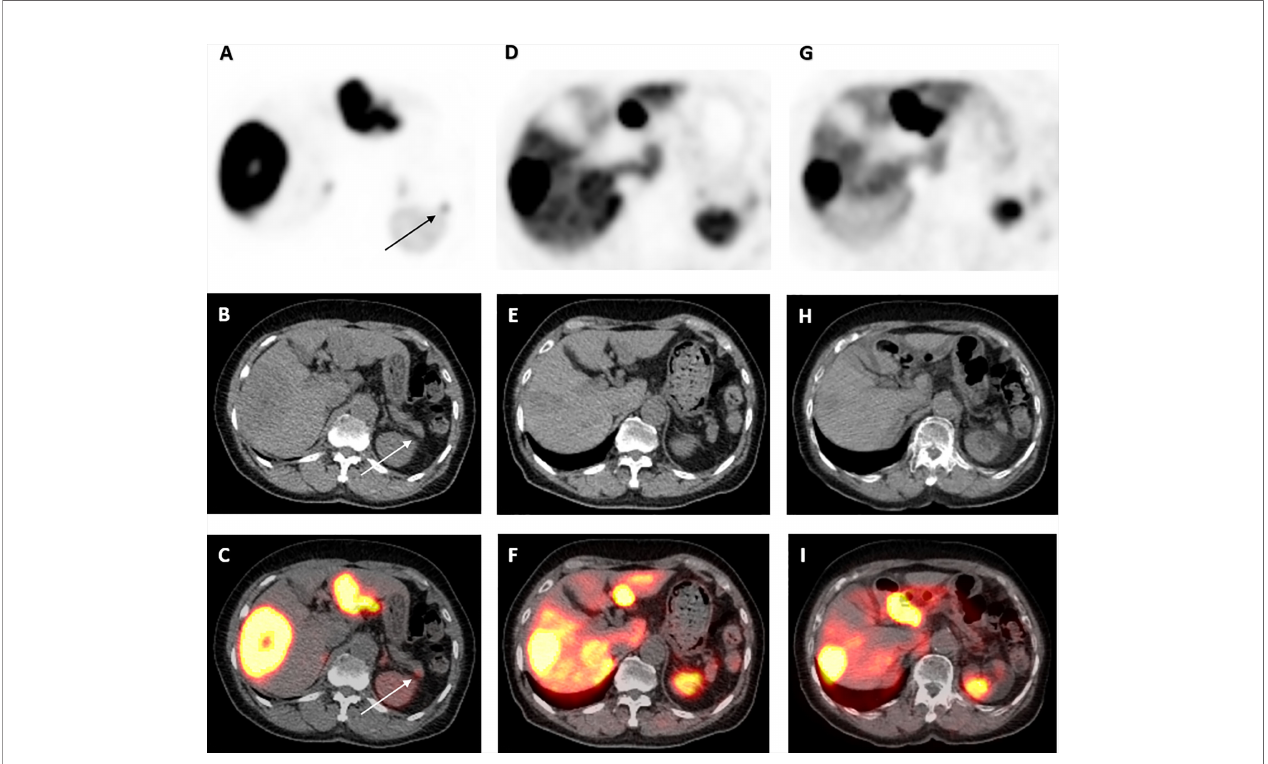
FIGURE 1 | 68Ga-DOTATATE PET/CT scan images of pancreatic tail lesion pre- and post-177 Lu-DOTATATE. Axial view images of 68 Ga-DOTATATE PET/CT scan demonstrating interval reduction in avidity in moderately intense focus of activity at the tip of the pancreatic tail (arrow) on PET, low-dose CT and PET/CT fusion (top to bottom) from baseline, to 1 and 4 years after 177 Lu-DOTATATE therapy (left to right). Physiological uptake in the spleen and remainder of the liver is also